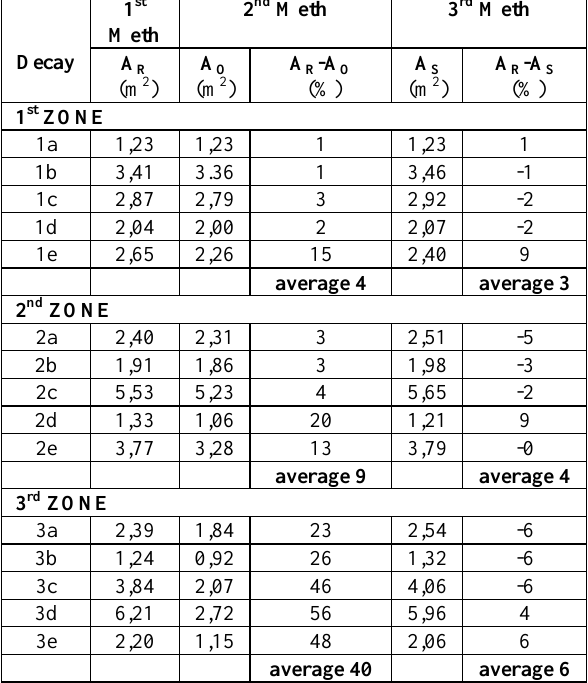
Table 2. Values of areas of decay measured through a 3D model (A R ), an orthophoto (A O ) and a scaled orthophoto (A S )